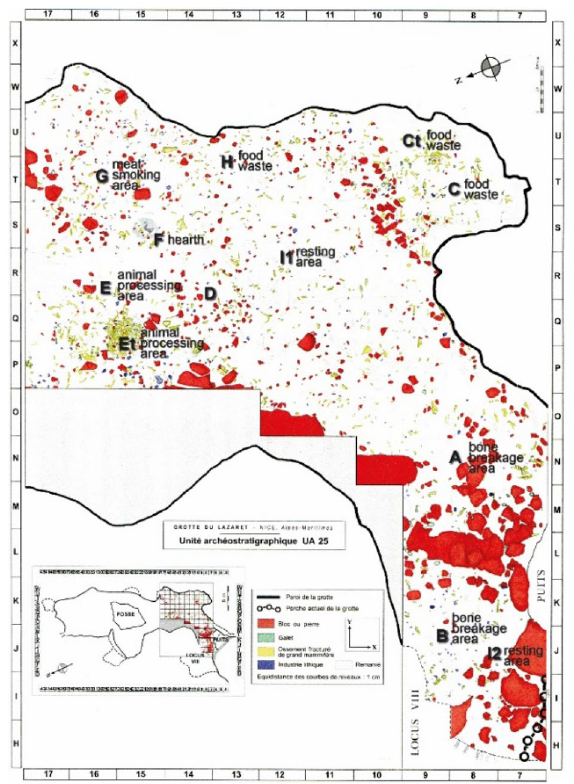
Figure 2. Lazaret cave, GIS map of UA25 with activity area, based on ( 65 , p. 172). The activity areas were designated by the excavators on the basis of the archaeological evidence (red—block and stonegreen—pebble, yellow—large mammal bone, blue—lithic pieces) (courtesy of Prof. Henry de